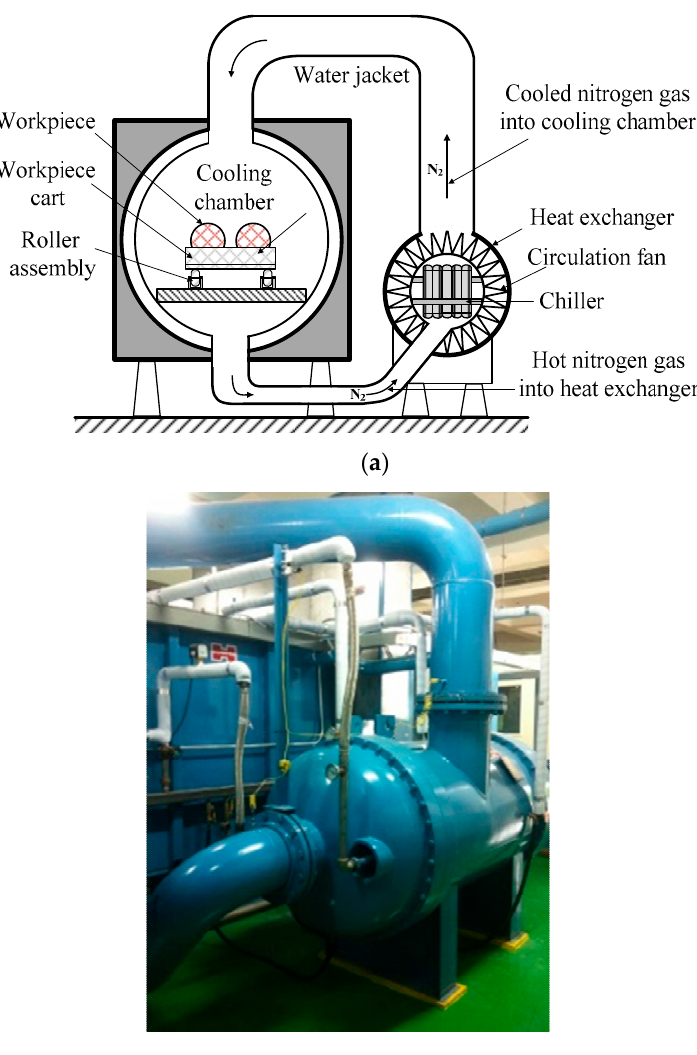
Figure 3. ( a ) Schematic drawing of closed loop nitrogen circulation; ( b ) photograph of the developed nitrogen cooling system.